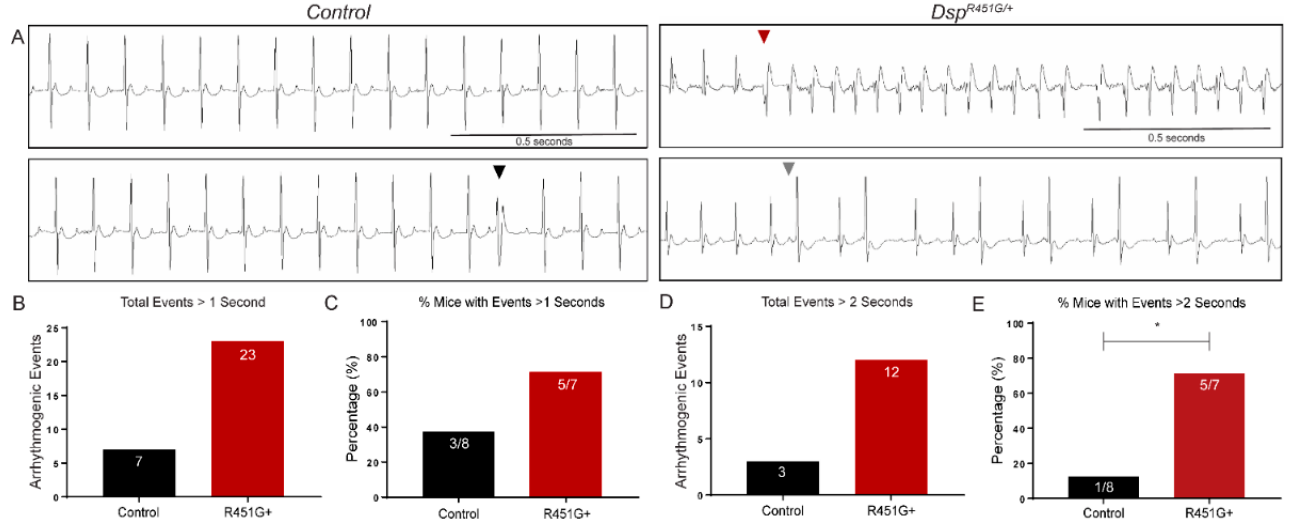
Figure 5. Dsp R451G/+ mice display arrhythmias following catecholaminergic challenge. ( A ) Repre- sentative ECG recordings of control and Dsp R451G/+ mice littermates (~3 months of age) following 2 mg/kg epinephrine. Arrowheads point to identified arrhythmic events, including isolated PVCs (Black), ventricular tachycardia (red), and bigeminy (gray). Scale bars represent 500 ms. ( B ) Ar- rhythmogenic events that exceeded 1 s per group. ( C ) Percentage of mice in each genotype with at least 1 event that exceeded 1 s. ( D ) Total number of arrhythmogenic events longer than 2 s. ( E ) Percentage of mice in each genotype with at least 1 event that exceeded 2 s. Stats performed using Fisher’s exact test * p < 0.05 (control n = 8, Dsp R451G/+ n = 7).